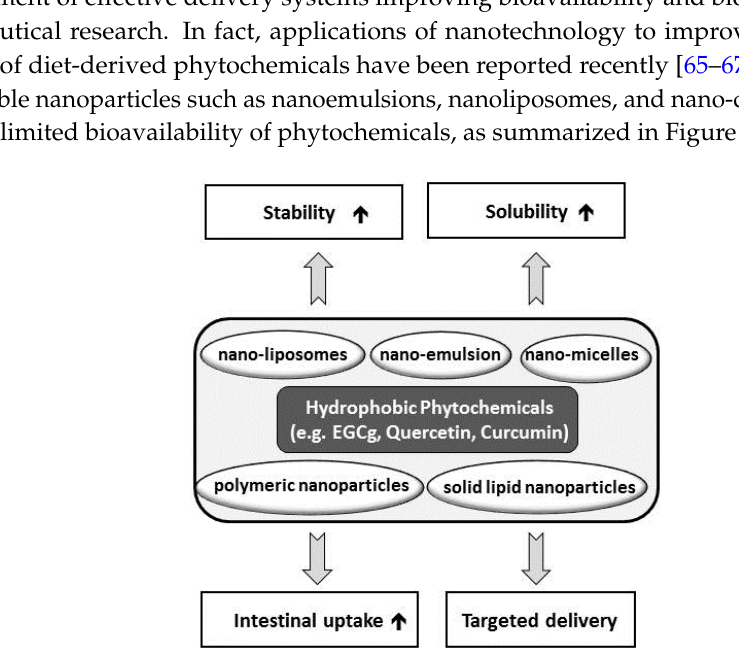
Figure 3. Application of nano-technologies improving bioavailability of natural products. EGCg, epigallocatechin gallate.